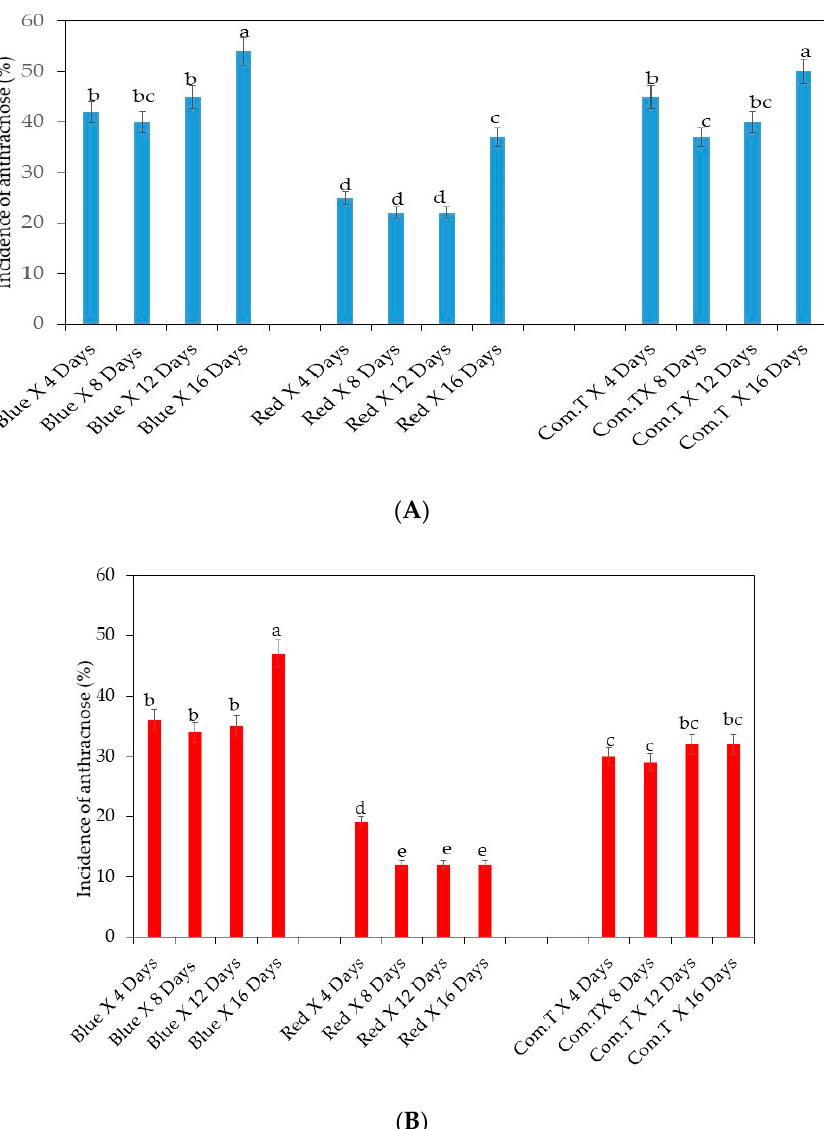
Figure 2. ( A ) Influence of LED light exposure on naturally infected avocado cultivar Fuerte. ( B ) Influence of LED light exposure on naturally infected avocado cultivar Hass. The exposure of fruit to blue or red LED light was for 6 h per day during storage. Ten replicate tray packs, each containing four fruit, underwent different postharvest treatments. Mean values of bars marked by different letters were significantly different at p < 0.05, according to Fisher’s protected LSD test. Blue, blue LED light; Red, red LED light; Com.T, commercial treatment.